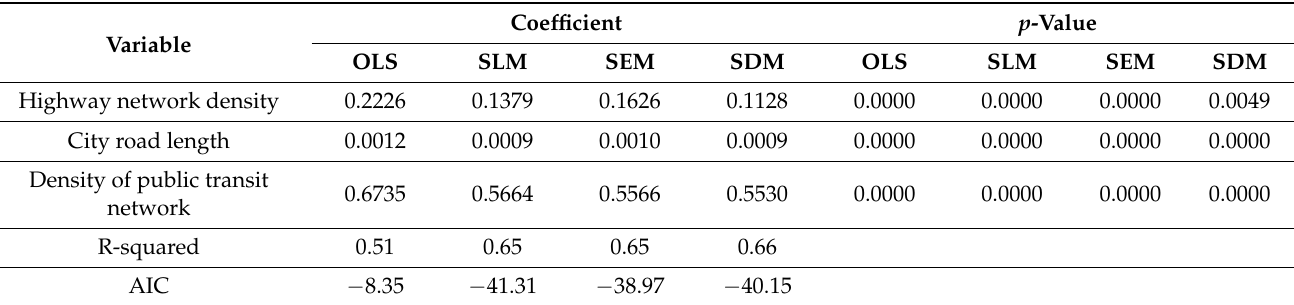
Table 4. Summary statistics of global OLS, SLM, SEM, and SDM